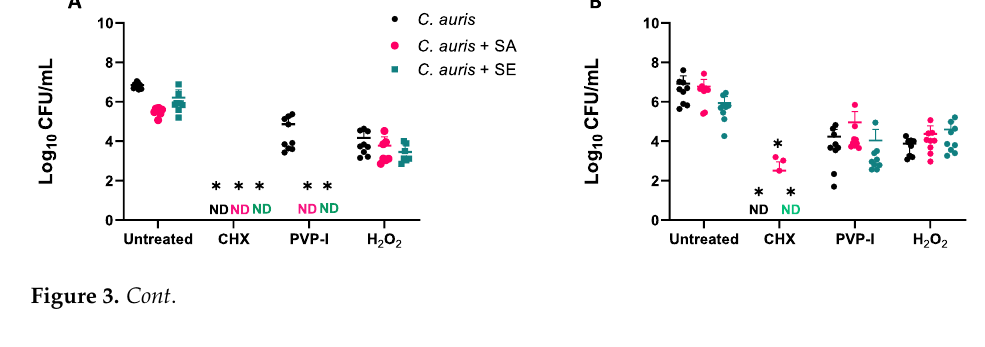
Figure 3. Multi-species biofilms do not provide additional protection against antiseptics. Single and dual-species biofilms of C. auris and either S. aureus (SA) or S. epidermidis (SE) were grown for